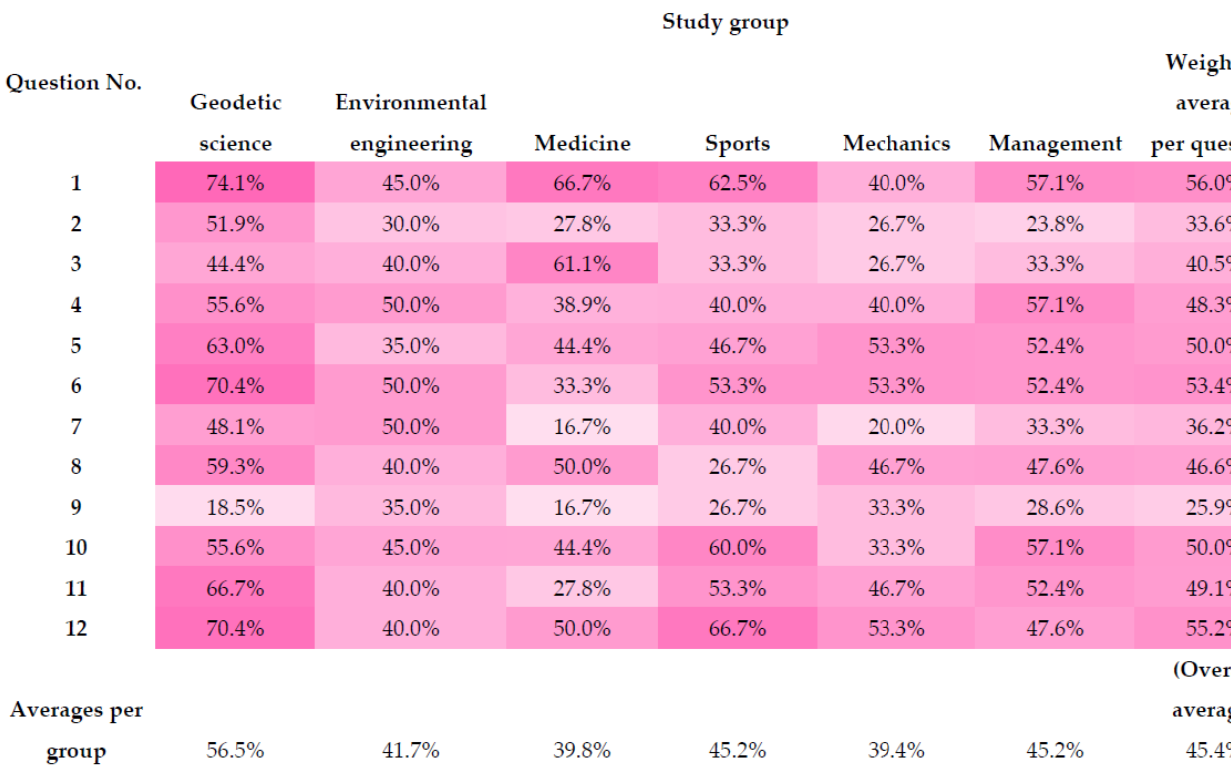
Figure 6. Percentage of correct answers given by women to questions 1–12 overall and in the study groups.